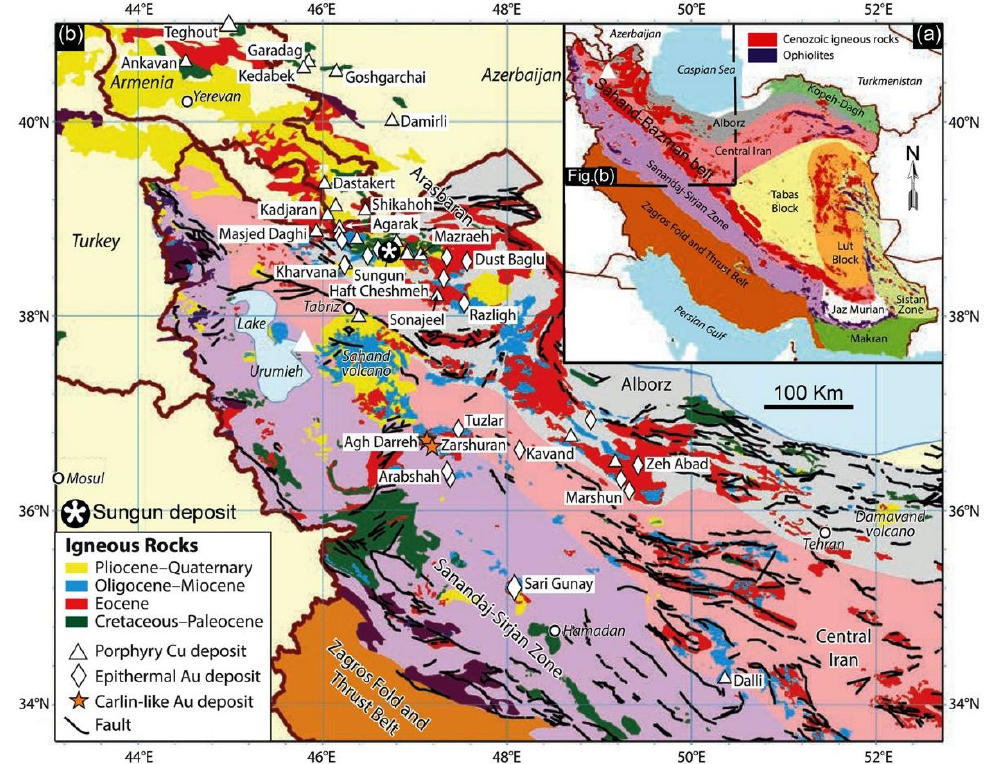
Figure 1. ( a ) Main tectonic terranes of Iran and neighboring countries. Additionally mapped are late Mesozoic and Cenozoic magmatic provinces as well as ophiolitic domains [1,7]; ( b ) geologic map of Northwestern Iran, showing the locations of Mesozoic and Cenozoic igneous rocks and associated porphyry, epithermal, and Carlin-like deposits [7]. The location of the Sungun porphyry Cu-Mo deposit in the Sahand-Bazman belt is shown by a star [8].